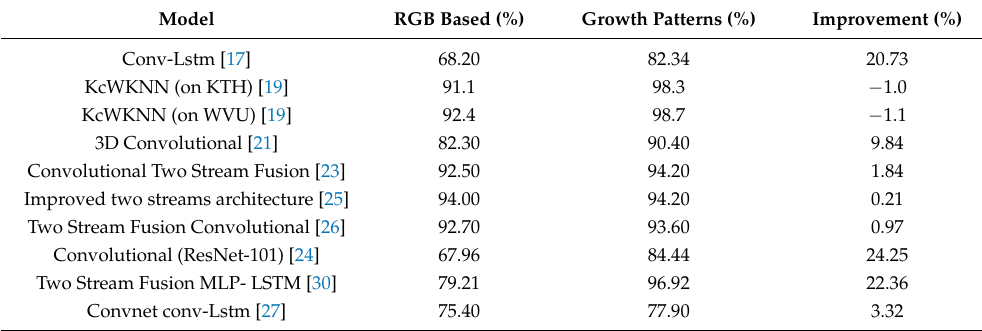
Table 7. Comparison with State-of-the-Art methods using the Average Accuracy Measure. Model RGB Based (%) Growth Patterns